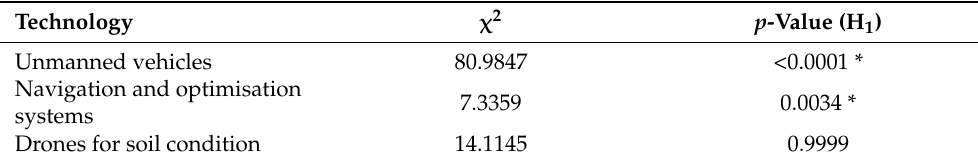
Table 2. The result of statistic evaluation for machines in crop